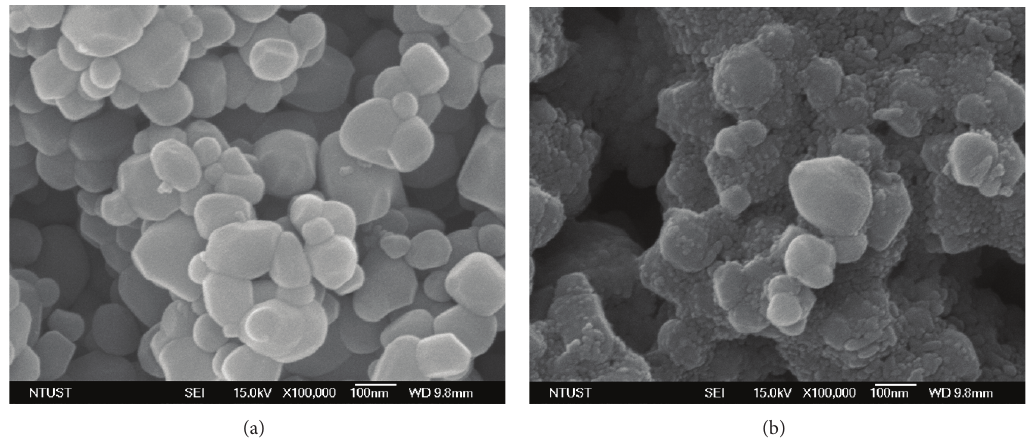
Figure 2: SEM images of (a) light-scattering layer of double layer TiO 2 films and (b) TiCl 4 posttreatment of light-scattering layer. Table 2: Photovoltaic parameters of the DSSCs with N719 :4L in different molar ratios under AM 1.5 G sunlight a . Dyestuff